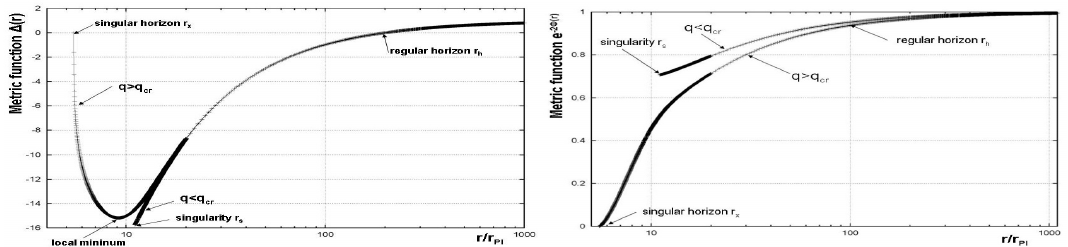
Figure 2. The dependence of the metric function ∆ and the dilatonic one e − 2 φ upon the radial coordinate r for q < q cr ( left curve) and q = 24.81 > q cr ( right one). Reproduced from